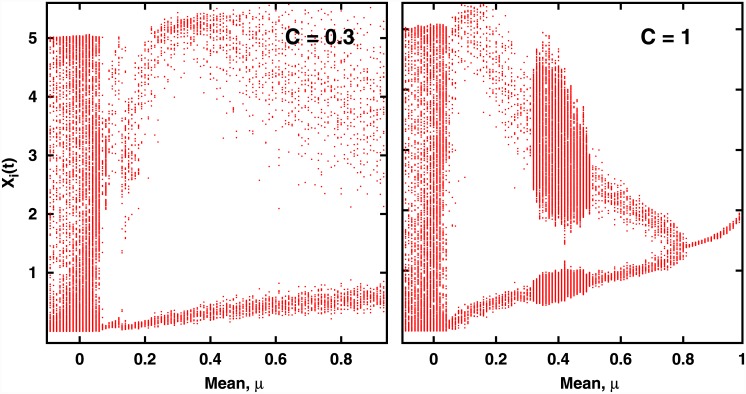
Bifurcation Diagram of the population dynamics of the network of 100 species, as a function of mean μ of the interaction strengths, for representative values of connectedness: (a) C = 0.3 and (b) C = 1.Here we show x
i(t), for all i = 1, … N, over a period of time, after transience. Standard deviation σ of J is 0.1. On careful observation we found that all bifurcation diagrams collapse on to a single pattern when viewed as a function of μC.